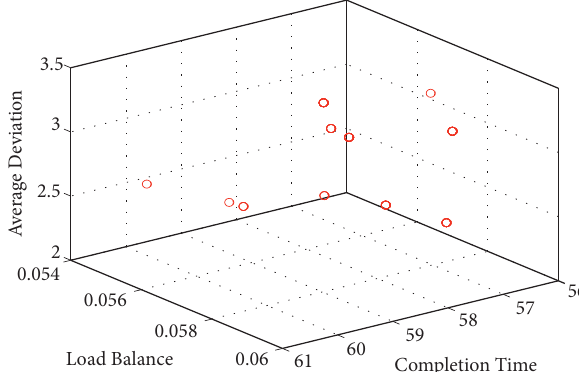
Figure 7: Nondominated graph optimization for rescheduling tasks at t � 52.1802.